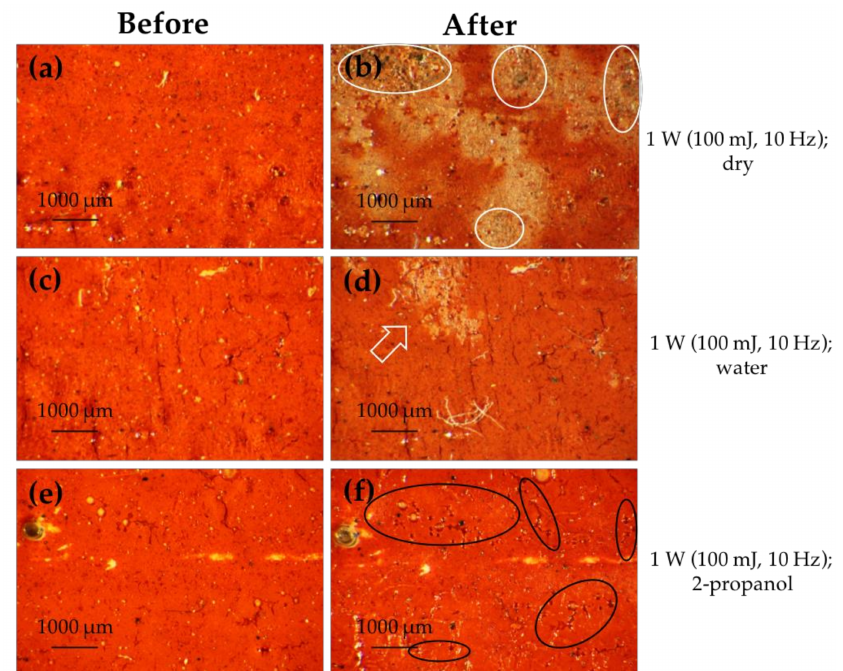
Figure 5. The microscopic images (32 × ) of P B67 removal by Er:YAG laser under varied conditions and parameters, conducted on cinnabar tempera mock-ups. ( a , c , e ) was obtained before cleaning, while ( b , d , f ) was obtained after cleaning in dry and wet conditions with 1 W as laser